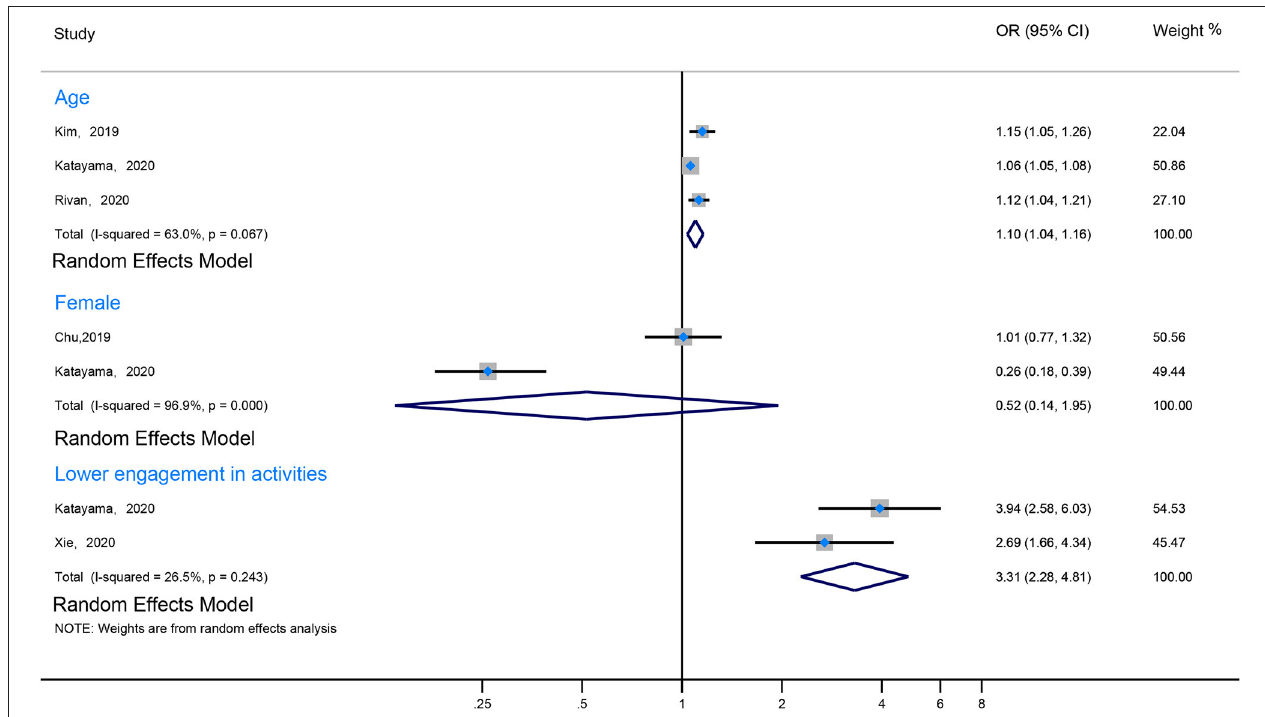
FIGURE 4 | The forest plot illustrated the associated risk factors about